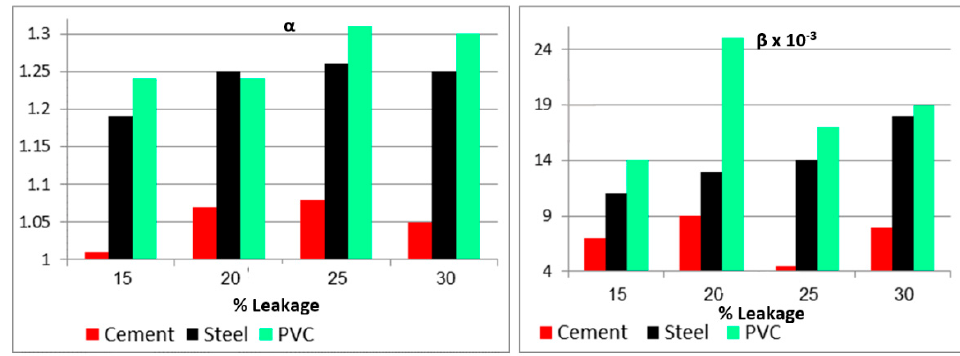
Figure 5. α i and β i results for different leakage and scenarios.